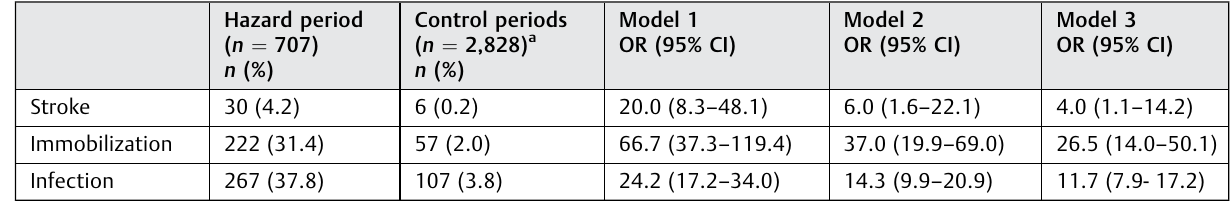
Table 2 Distribution of triggers in the hazard and control periods and odds ratios (ORs) of venous